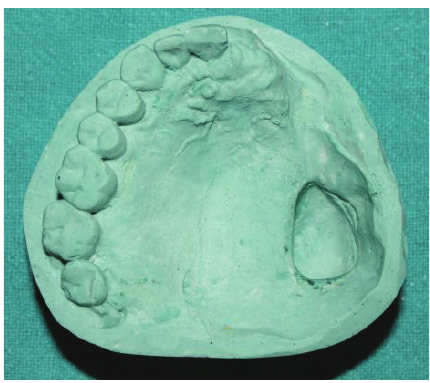
Figure 1: Extraoral examination.